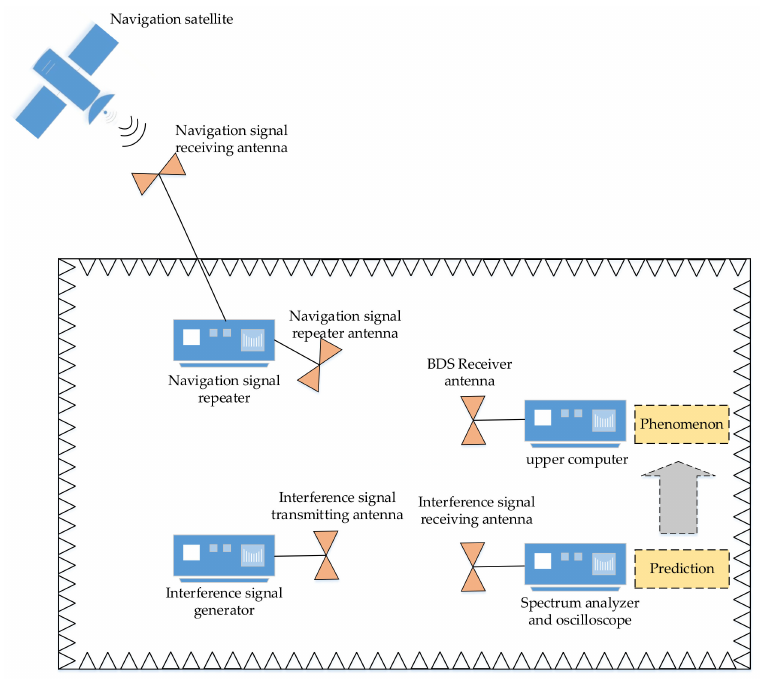
Figure 13. Experimental design block